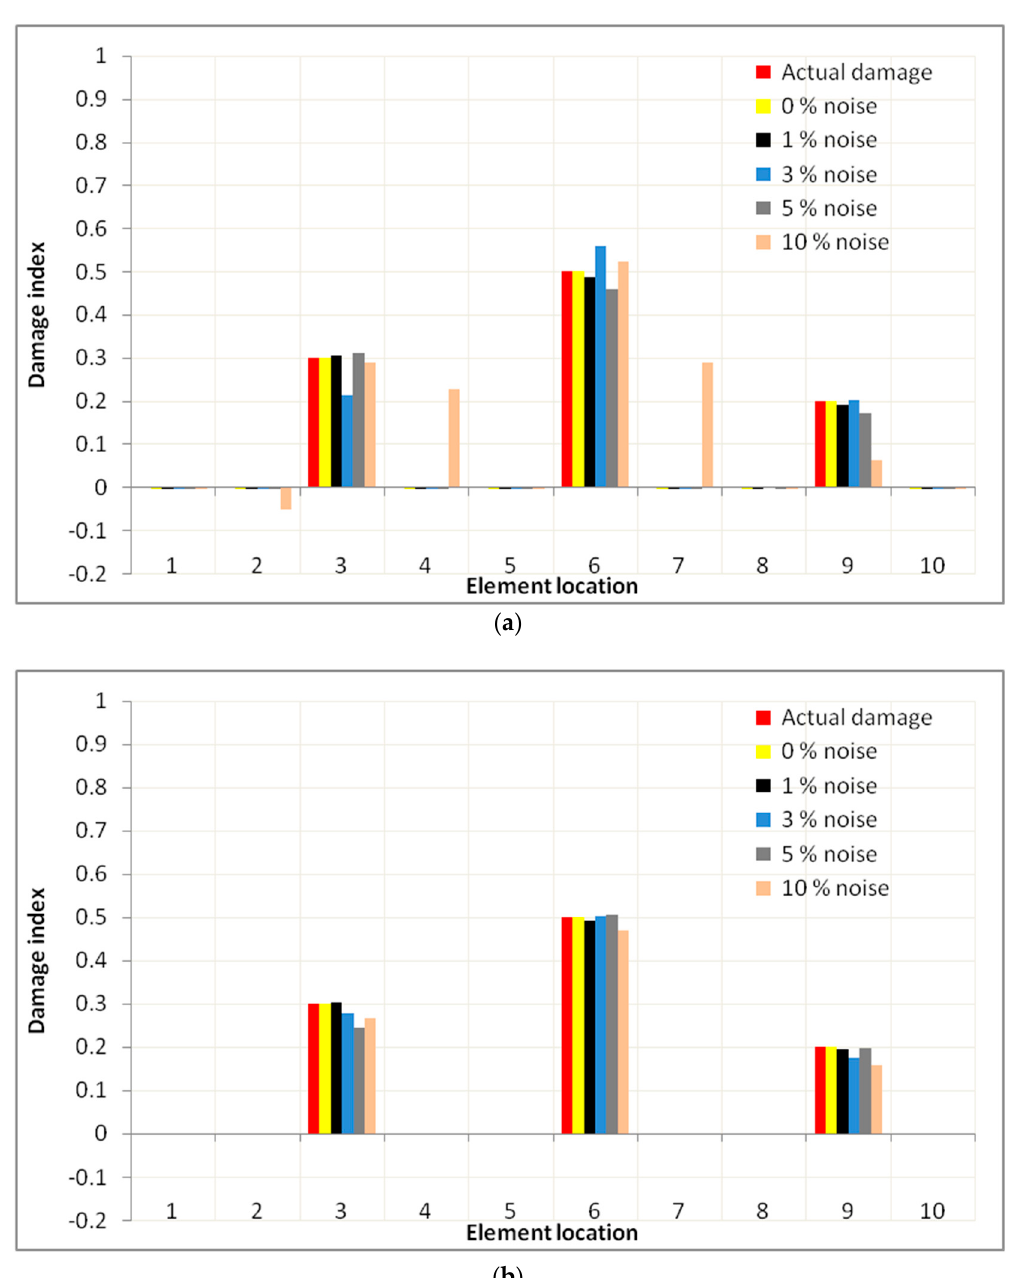
Figure 12. Damage distribution for Case 2 using Objective Function Iwith regularization for ( a ) noise both in frequency and mode shapes and ( b ) noise in mode shapes only.